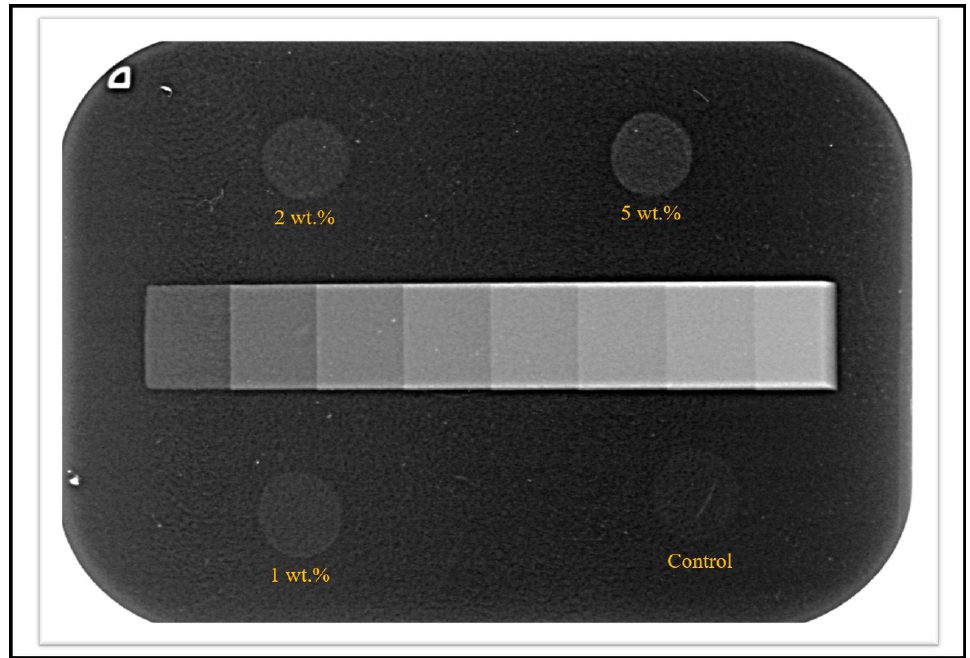
Figure 3. X-ray image obtained in the digital system. One sample per group was exposed to an aluminum step-wedge to compare the radiopacity achieved for each experimental adhesive. We observed a higher immediate μ -TBS in the group with 5 wt.% of LiNbO 3 compared to the control group ( p = 0.035), but no differences to the 1 wt.% and 2 wt.% groups ( p = 0.498 and p = 0.623, respectively). After six months of storage in distilled water at 37 °C, there was a drop in the μ -TBS values for the specimens in the groups with 1 wt.% and 2 wt.% of LiNbO 3 . There was no significant difference in the control group ( p = 0.99) and the group with 5 wt.% LiNbO 3 ( p = 0.365) when